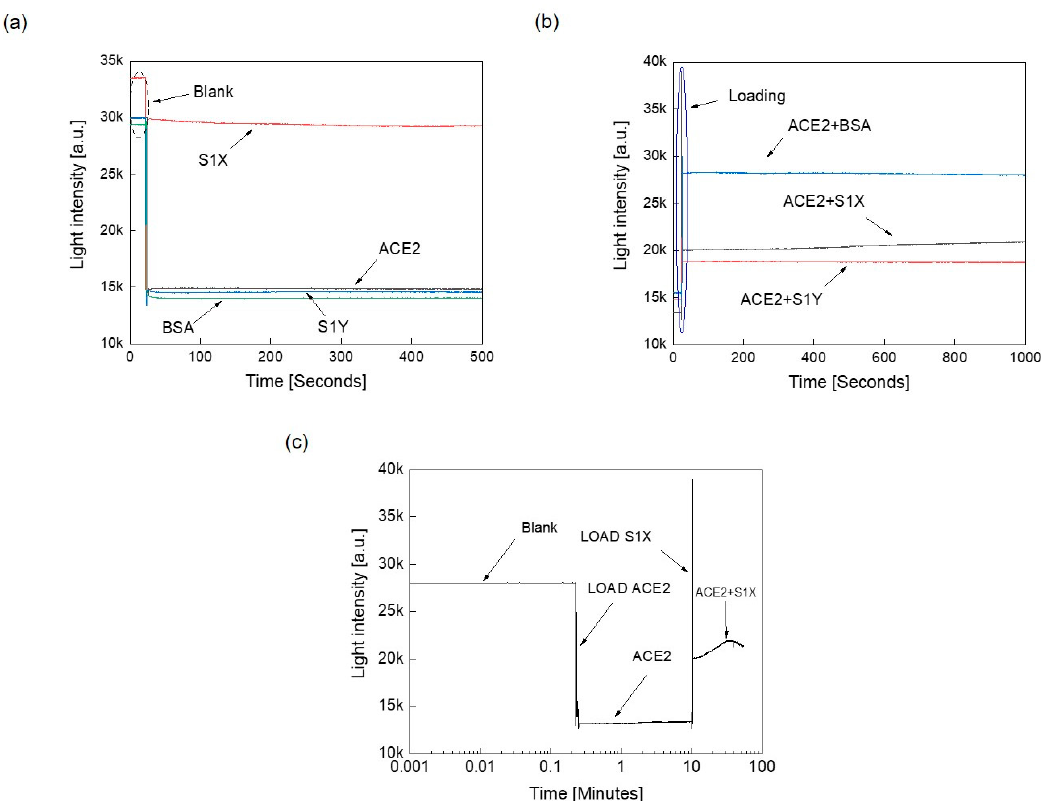
Figure 5. Optical detection of binding interactions between ACE2 and other proteins. ( a ) Measured light intensities over time for individual assessment of ACE2, S1X, S1Y, and BSA. ( b ) The measured mixed light intensities vs. time for ACE2 mixed with S1X, S1Y, or BSA. ( c ) The measured ACE2–S1X interaction profile for an extended time period.